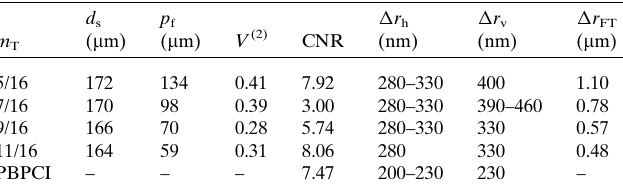
Table 2 Summary of different setup and reconstruction quality parameters for the realized Talbot orders m T : the shear distance d s of the grating interferometer, the fringe period p f , the visibility V (2) corresponding to terms with n (cid:3) m = 2 from equation (5), the contrast-to-noise ratio (CNR), the resolution estimates (cid:2) r h and (cid:2) r v in the horizontal and the vertical direction, and the resolution limit (cid:2) r FT of the Fourier transform method in the vertical direction due to the fringe